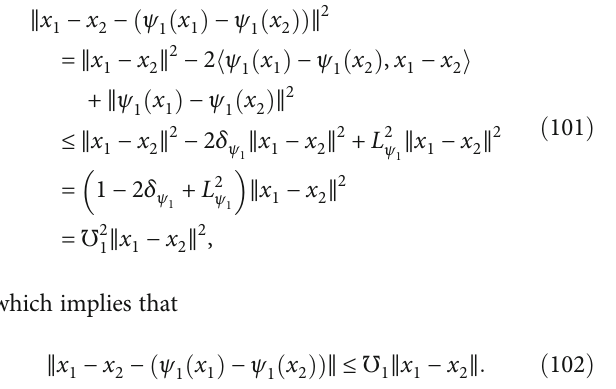
Algorithm 14. Let Ω 1 and Ω 2 be nonempty closed